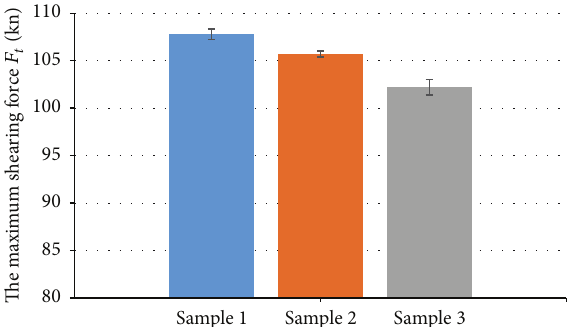
Figure 14: The maximum shearing force of the AlMg3 aluminium alloy-X10CrNiTi189 austenitic steel joint (according to [26]).